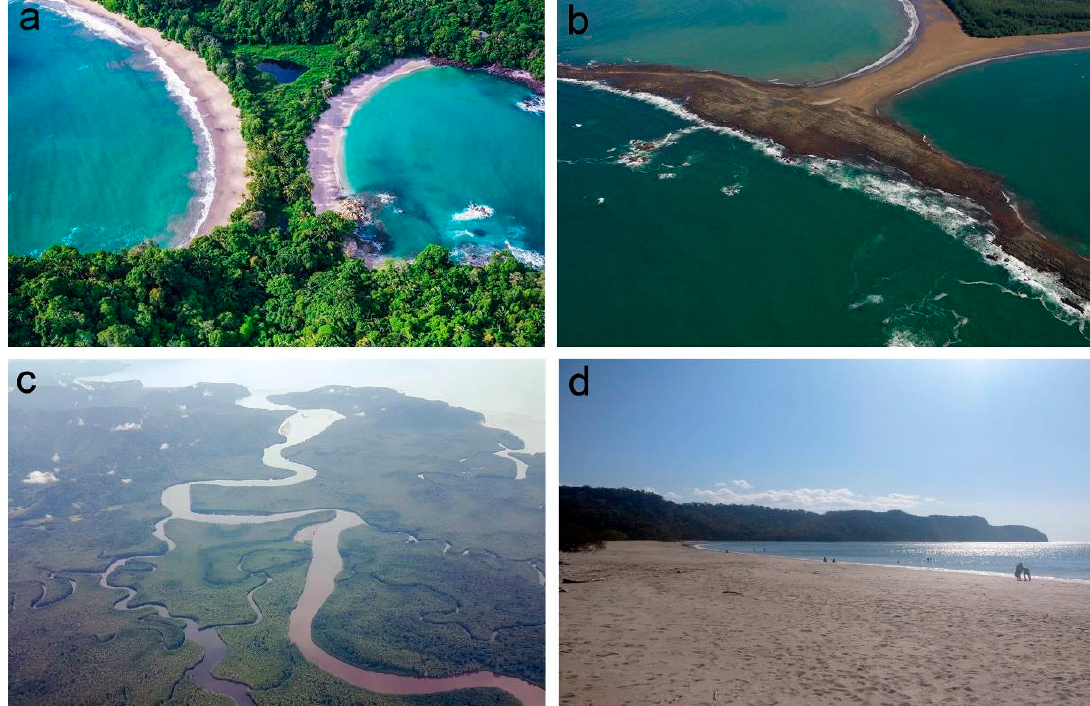
Figure 7. Pacific basin fluvial and coastal landforms: ( a ). Punta Catedral, tómbolo at Manuel Antonio National Park (courtesy of Mario Murillo); ( b ). Punta Uvita at Marino Ballena National Park (photo courtesy of Leonel León); ( c ). Delta at Térraba-Sierpe National Wetland (photo courtesy of Néstor Veas); ( d ). Cabuyal beach, Liberia.